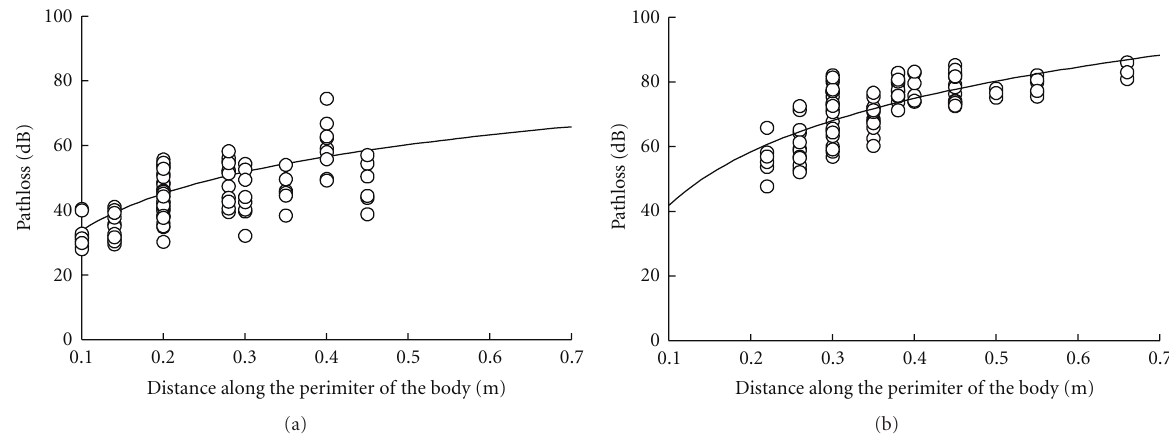
Figure 5: Ultrawideband pathloss onbody antennas measured in a radio anechoic chamber: (a) LOS and (b) NLOS.